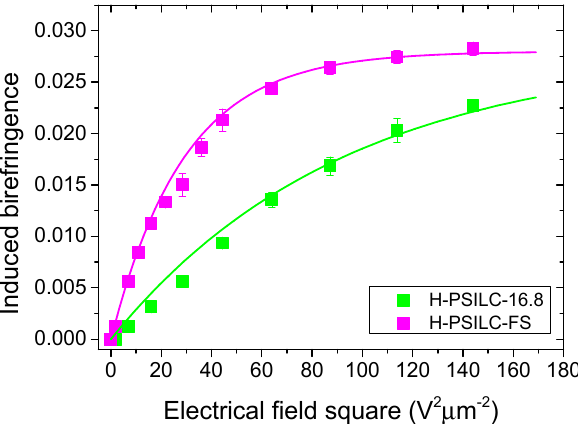
Figure 7. The induced birefringence in PSILC cells and correspondence of the fitting curves, in accordance with Equation (2).